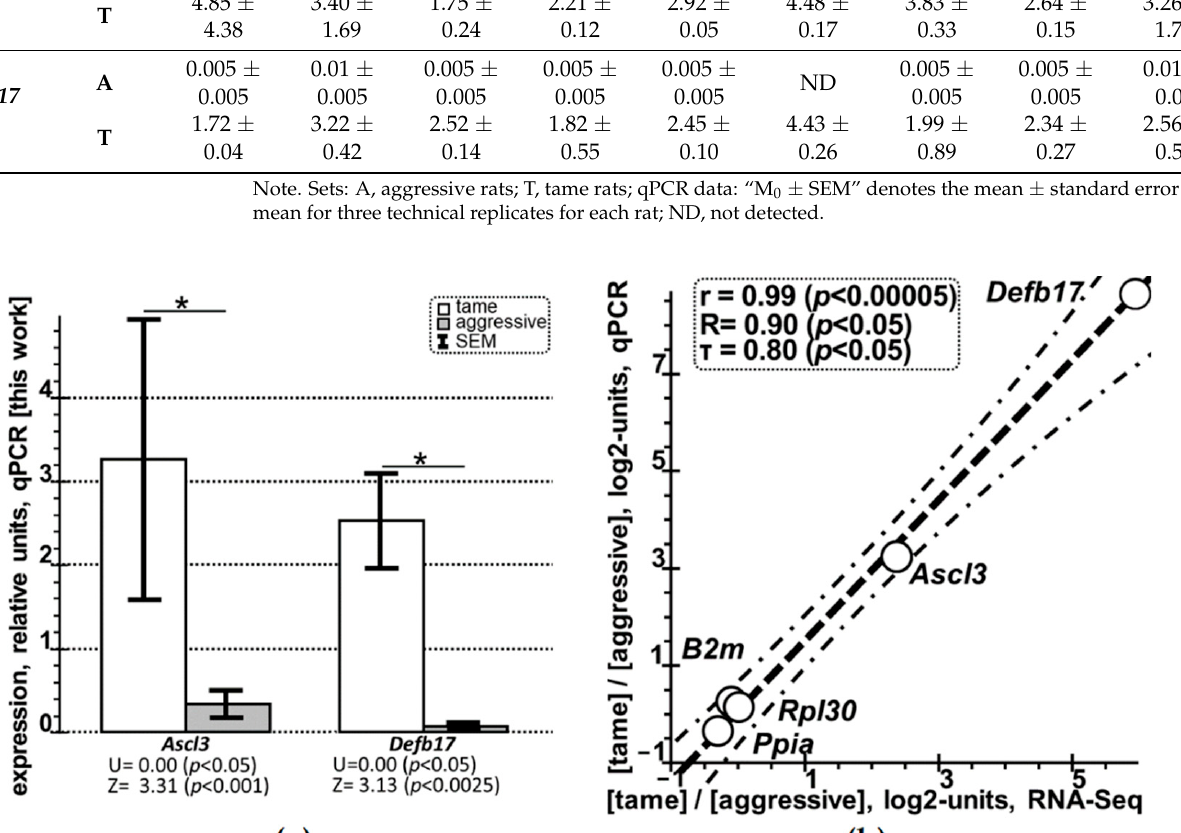
Defb17 are significantly overexpressed in the hippocampus of the tame (white bars) versus aggressive (grey bars) rats according to the qPCR data obtained here (Figure 1a: p < 0.05, asterisks), consistently with the RNA-Seq data (Table 2). Figure 1b depicts a significant Pearson’s linear correlation ( p < 0.00005), Spearman’s rank correlation ( p < 0.05), and Ken- dall’s rank correlation ( p < 0.05) between the log2 values (hereinafter, log2: the log2-trans- formed ratio of an expression level of a given gene in tame rats to that in aggressive rats) for five genes— Ascl3 , Defb17 , B2m , Ppia , and Rpl30 (open circles)—within the RNA-Seq (X-axis) and qPCR (Y-axis) data obtained here. 2.3. Comparison of the Known DEGs (of Hypertensive versus Normotensive Animals) with Their Homologous Genes among the 42 Hippocampal DEGs (of Tame versus Aggressive Rats) Identified Here In this study, using the PubMed database [69], we compiled all the transcriptomes (that we could find) of hypertensive versus normotensive animals, as presented in Table 4. The total number of DEGs was 4216 in 14 tissues of four animal species, as cited in the rightmost column of Table 4 [7,40–57].